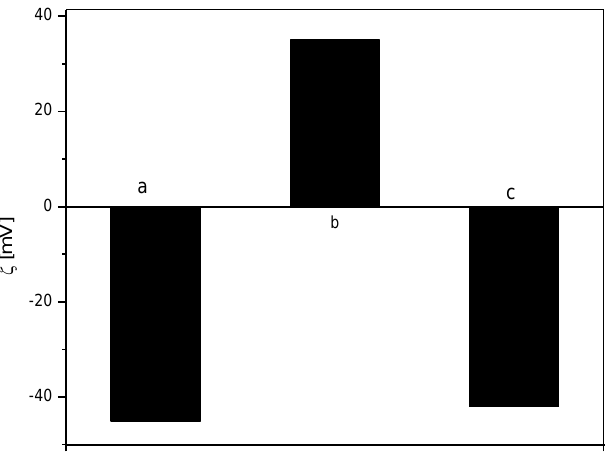
Figure 4. Zeta-potential of the initial (PSS-DoTAB, a), intermediate (PSS-DoTAB/Chitosan, b) and final (PSS-DoTAB/Chitosan/PSS, c) capsules with Vitamine E [24].